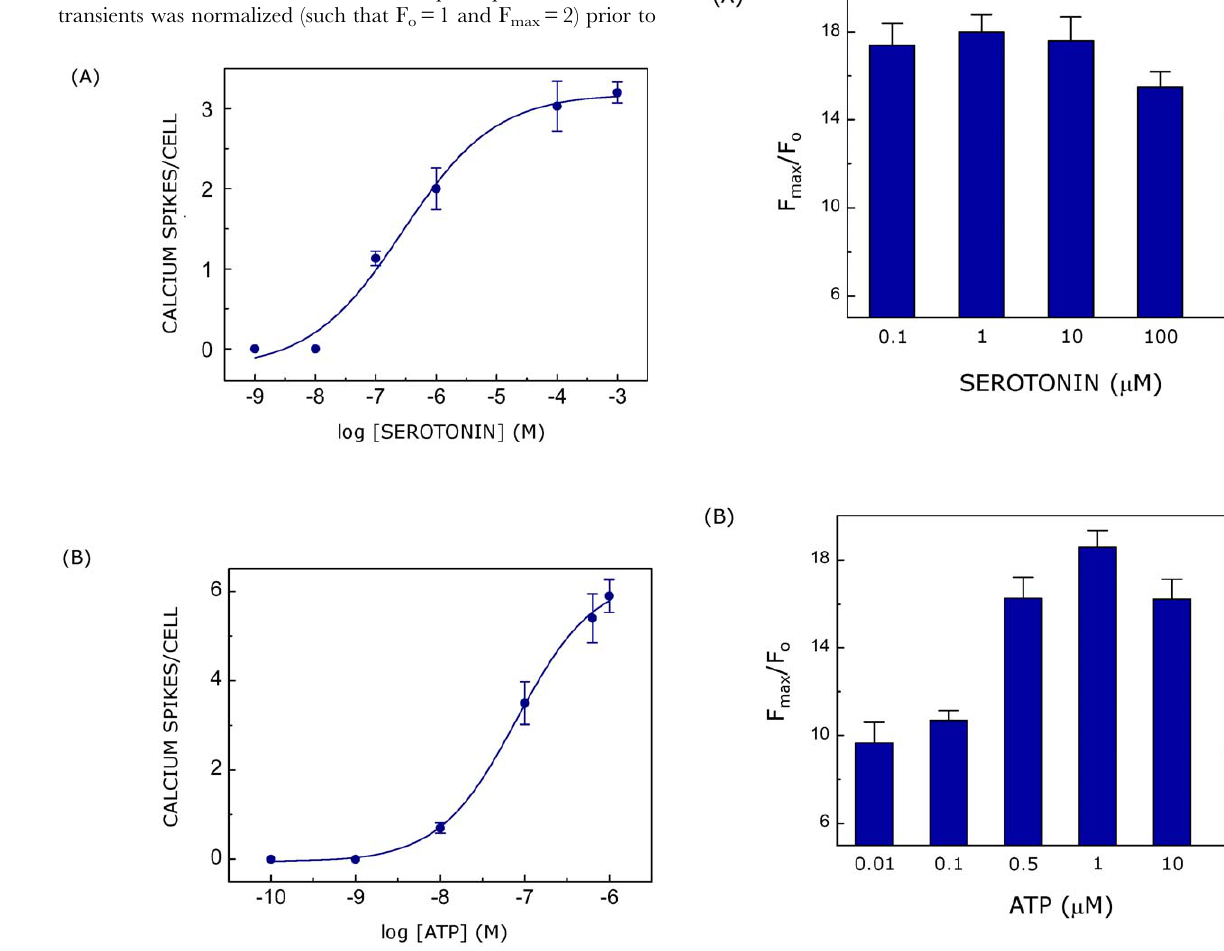
Figure 2. Dose response plots for calcium signaling induced by ligands in CHO-5-HT 1A R cells. The figure shows calcium response in terms of a number of calcium spikes visualized per cell induced with either (A) serotonin or (B) ATP. The curves are nonlinear regression fits to the experimental data using eqn. 1. Data represent means 6 SEM of more than 30 cells from at least four independent experiments. See Materials and Methods for more details.